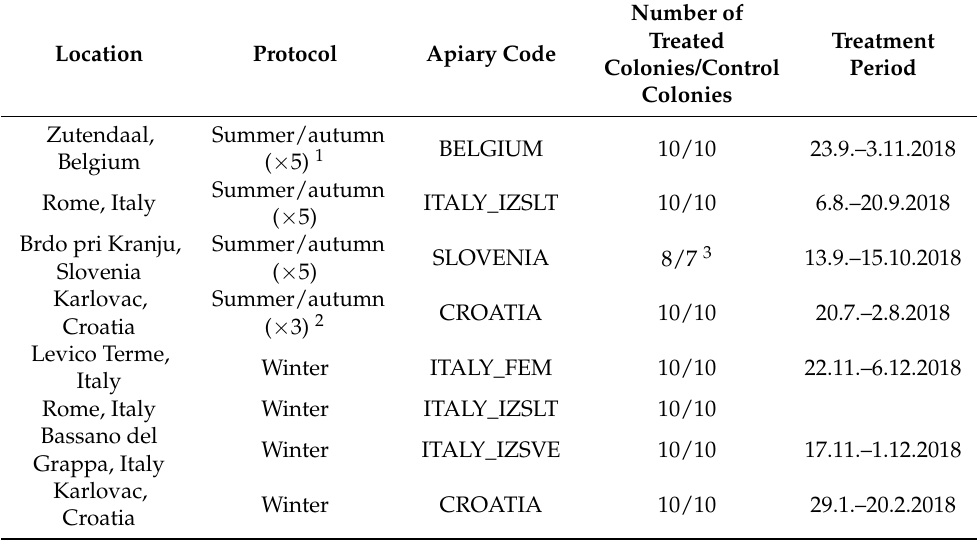
Table 1. Number of hives used in each trial and location. Location Protocol Apiary Code